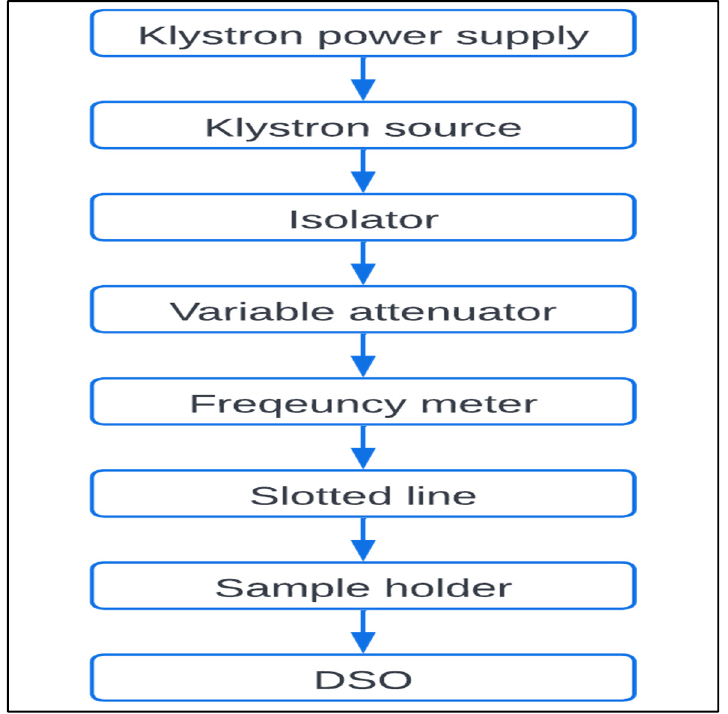
Figure 1. Block diagram for waveguide